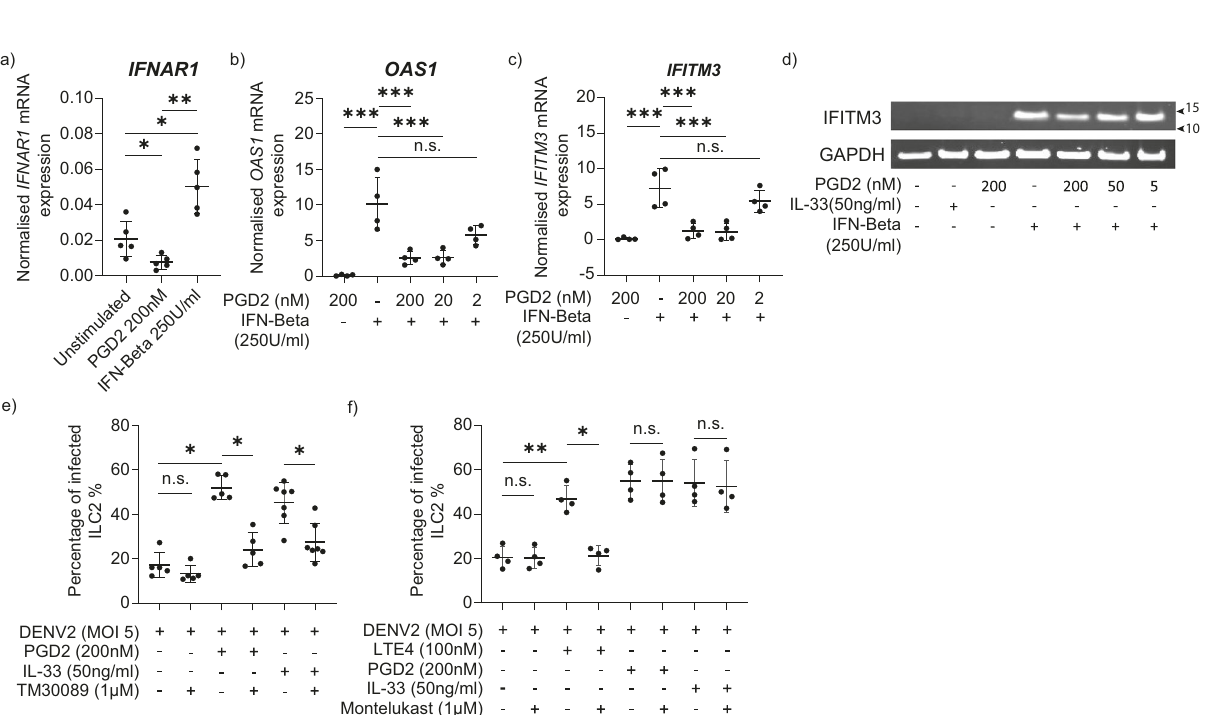
Fig. 3 In vivo ILC2 show impaired type I IFN signature in severe Dengue. a Gene ontology (GO) enrichment analysis comparing highly expressed genes